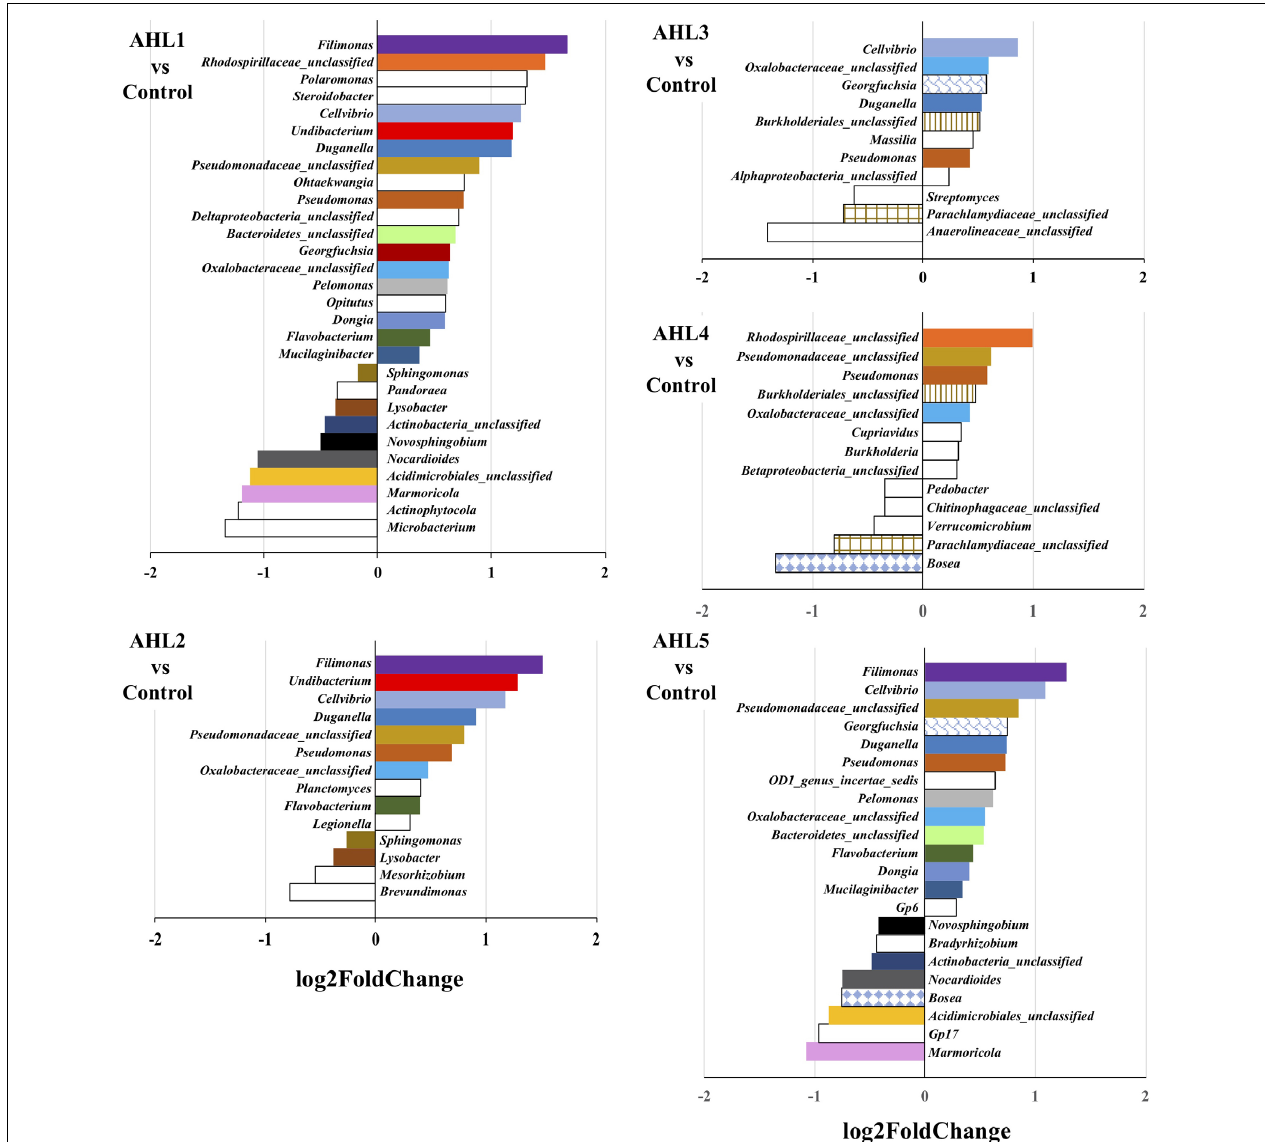
FIGURE 4 | Genus-level differences of the bacterial community composition between each induction assay of N-(Butyryl, Hexanoyl, β -Ketocaproyl, Heptanoyl, Octanoyl, 3-Oxododecanoyl, Tetradecanoyl, and 3-Oxotetradecanoyl) homoserine lactones (indicated by AHL1–8, respectively) and the control suspensions. Only statistically significant differences ( P < 0.01) were shown. The direction of bars represents decreases (left) or increases (right) in relative abundance of the specific bacterial taxonomic group after the induction assays relative to the unamended controls. Differential analysis of bacterial taxonomic abundances between the treatment and control group was performed using the DESeq2 package for R (Love et al., 2014). Variance mean was estimated over all treatments (each was based on three replicate assays and treated independently and identically). The color of the bar represents taxonomic group shared by two or more different treatments, and the bars without fill represent the taxonomic groups with significant differences compared with the control only detected in the current